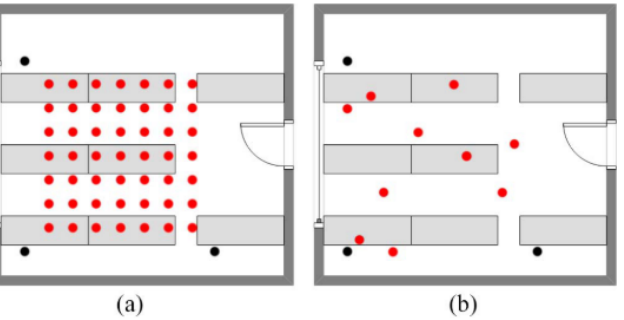
Figure 2. The environment of scenario 1. ( a ) Training data points. ( b ) Testing data points. The three black dots are AP locations, and the red dots are measuring points.